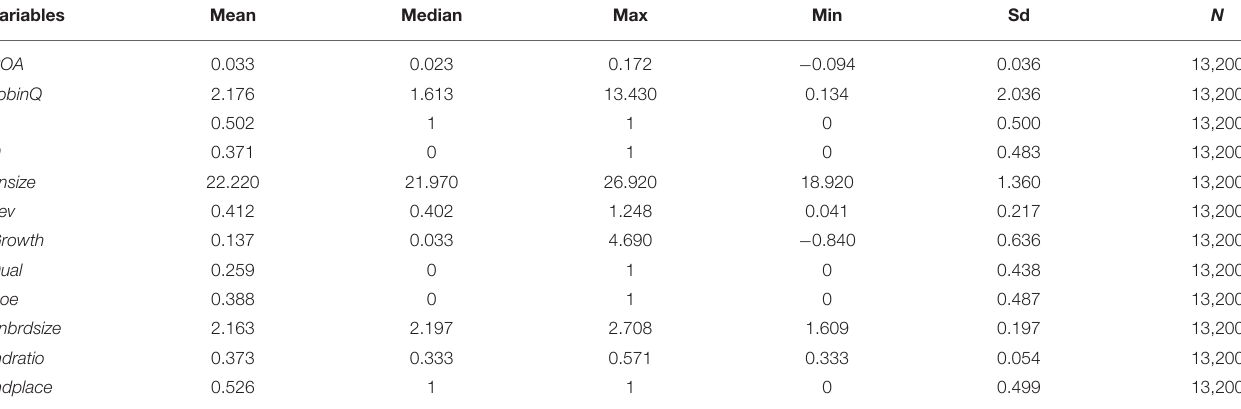
TABLE 3 | Descriptive statistics.